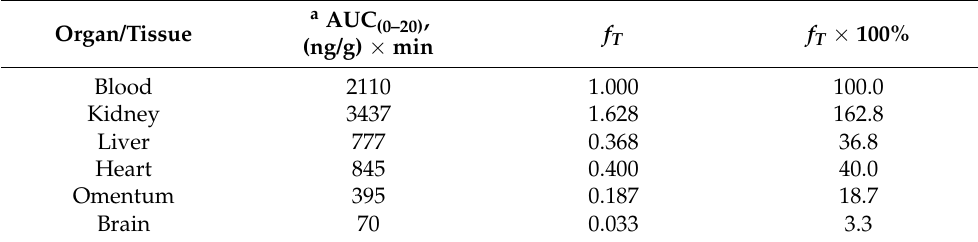
Table 3. Evaluation of HAEE bioavailability ( f T ) for several organs/tissues of mice after intraperi- toneal bolus administration at a dose of 300 µ